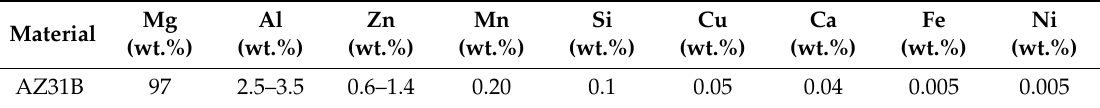
Table 1. Chemical composition of magnesium alloy